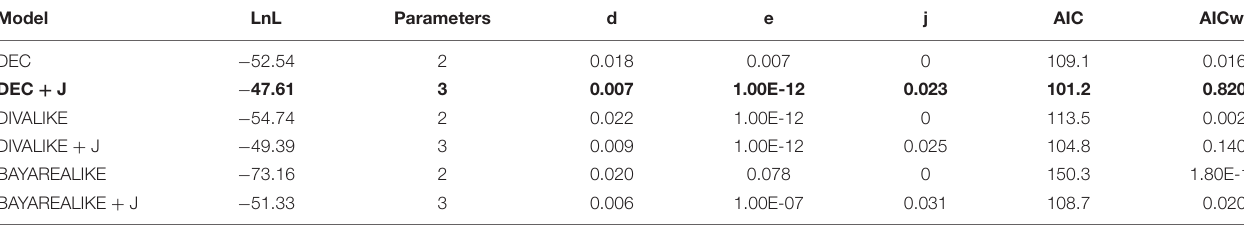
TABLE 1 | Results of the six biogeographic models implemented by BioGeoBEARS on the ancestral range estimation of Sciurini in a global scale. Model